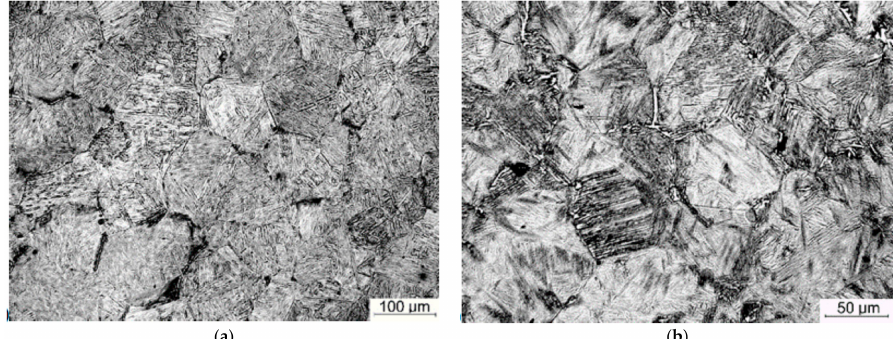
Figure 6. Microstructures of steel B before the first deformation ( a ) and after the last deformation ( b ).